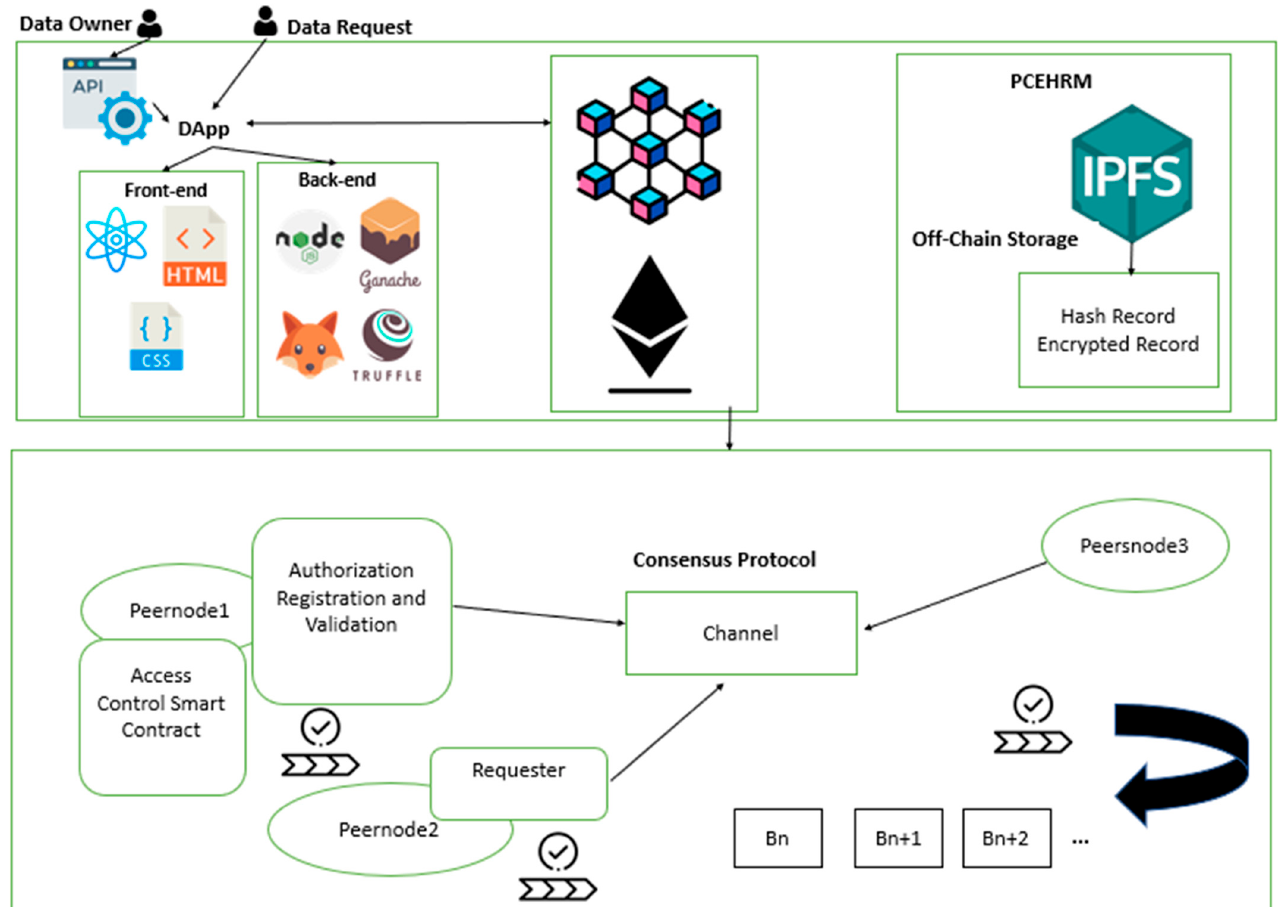
Figure 3. PCEHRM structure.